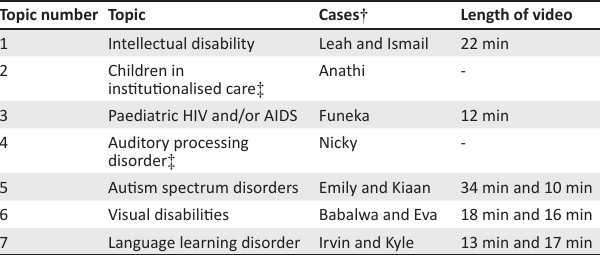
TABLE 1: Lecture topics and description of presented